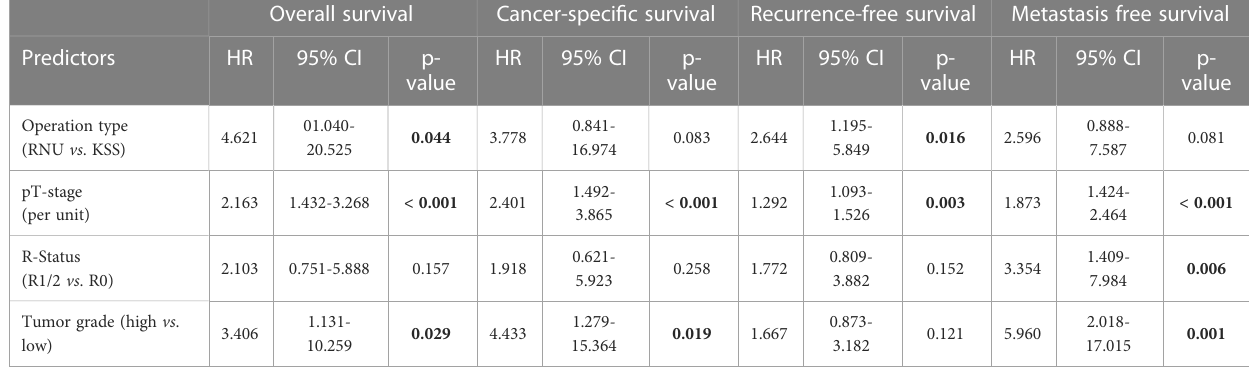
TABLE 3 Age- and sex-adjusted predictors for patient survival; HRs estimated with Cox proportional hazards regression analysis.